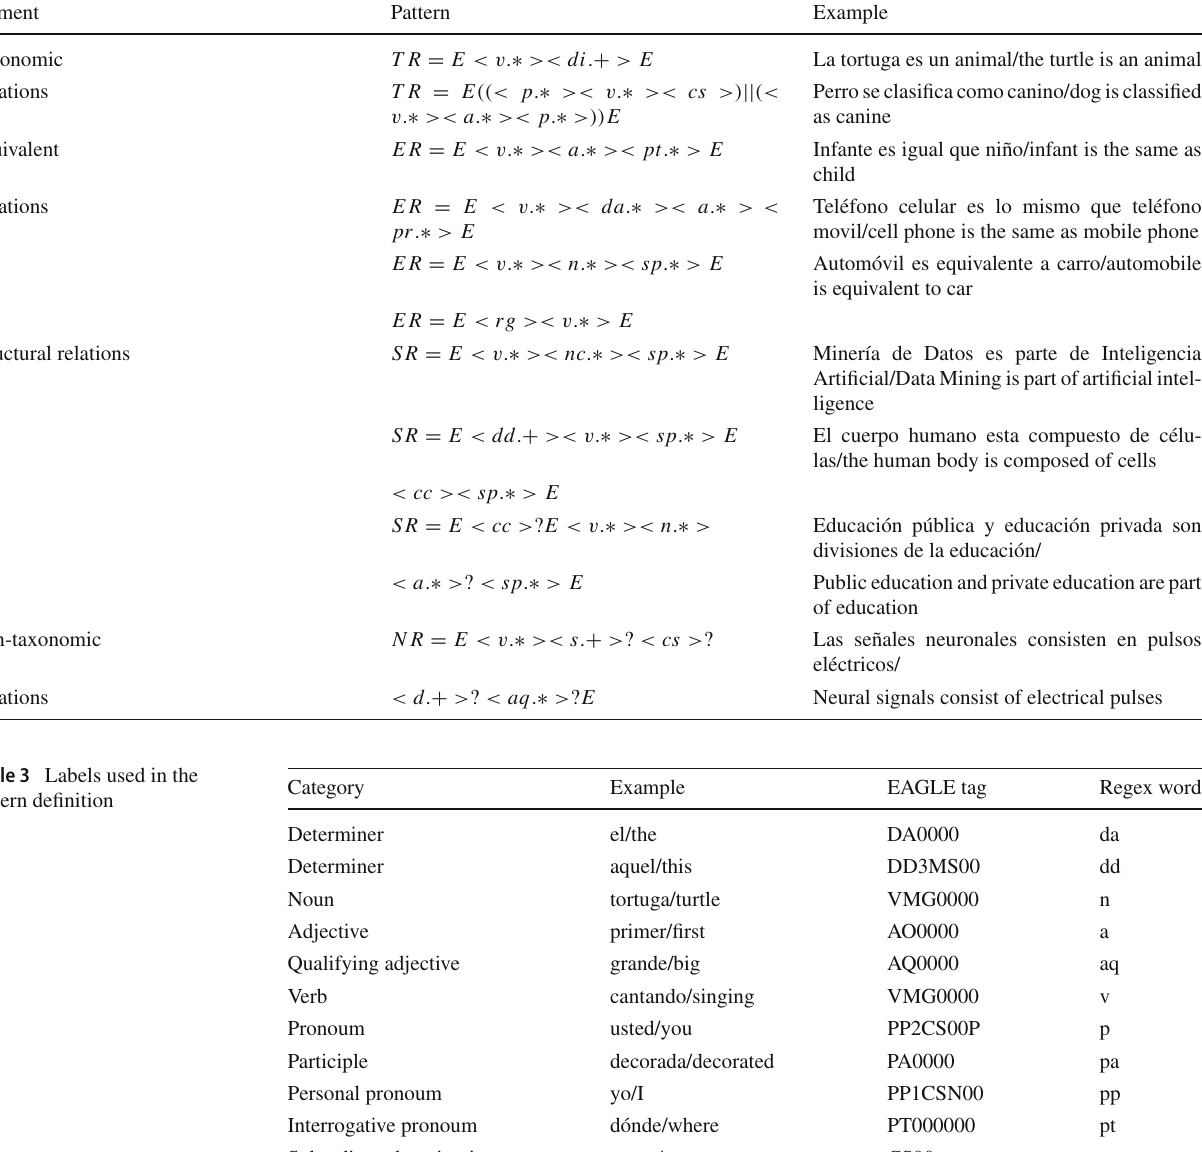
Table 2 Patterns used for the identification of relations in Spanish Element